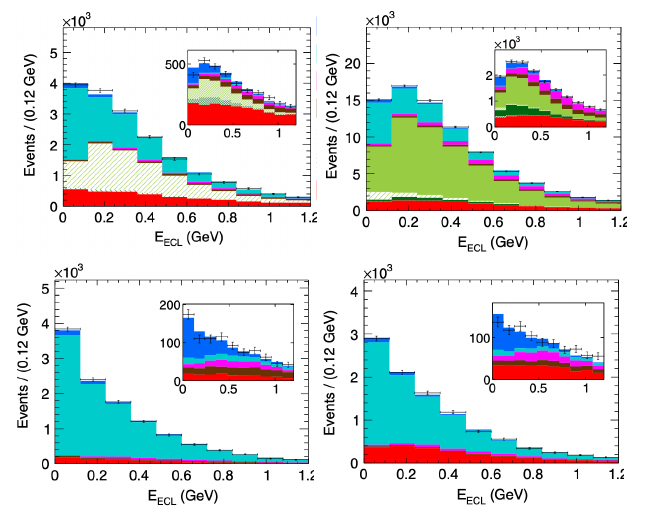
Figure 2. E ECL fit projection and data points with statistical uncertainties in the D + ` − (top-left), D 0 ` − (top-right), D ∗ + ` − (bottom-left), and D ∗ 0 ` − (bottom-right) samples. The signal enhanced region is shown in the